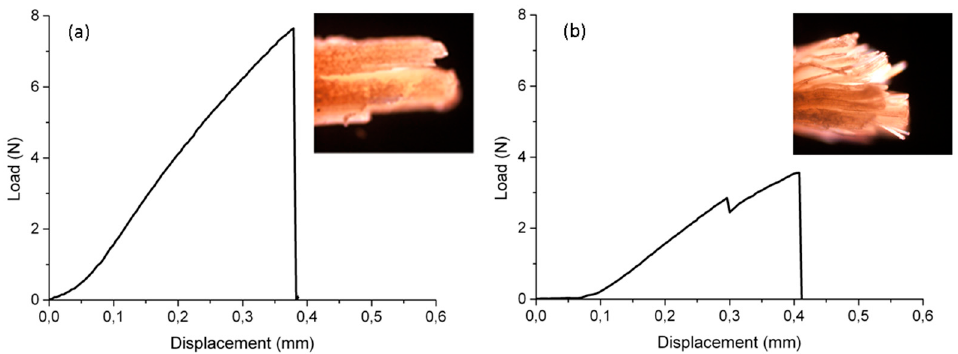
Figure 3. Typical load vs. displacement curves obtained by pull-out tests performed on bamboo fibers embedded in a PLA matrix: ( a ) adhesive failure at the bamboo/PLA interface and ( b ) adhesive failure combined with cohesive failure within the bamboo fiber. The pictures on the top right corner of each curve show the typical aspect of the fiber tips after the pull-out test: ( a ) regular and ( b ) non-regular fiber. Regular fibers were defined as those that did not show an obvious fibrillation, i.e.,